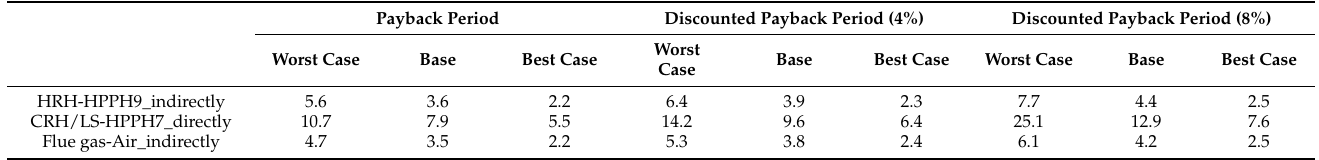
Table 12. Payback period in years for investment costs (without integration costs).